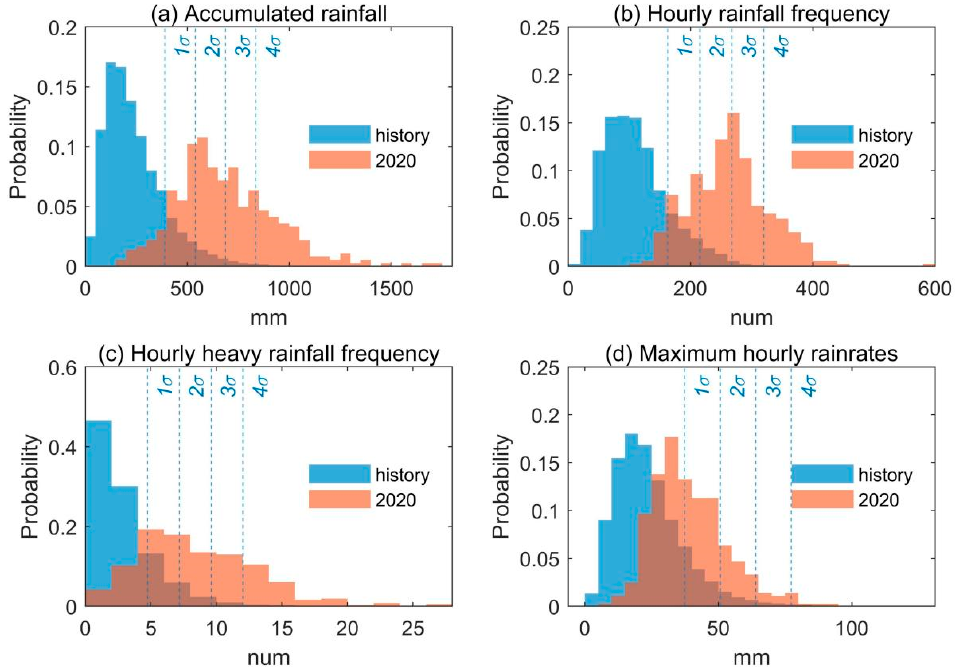
Figure 12. ( a ) The probability density distribution of the accumulated rainfall at national rain gauges over the YHRB during June–July 2020 (orange bars) and the historical Meiyu seasons in 1980–2019 (blue bars). The blue dashed lines mark the thresholds of a positive standard deviation of 1 to 4 from that of the historical mean, corresponding to the top 68%, 95%, 99.7%, and 99.9% of the historical distribution. ( b – d ) This is similar to ( a ) but for the hourly rainfall frequency, the hourly heavy rainfall ( ≥ 15 mm h − 1 ) frequency, and maximum hourly rain rates. The hourly rainfall frequency is counted as the number of records at 1 h intervals with rainfalls of no less than 0.1 mm.